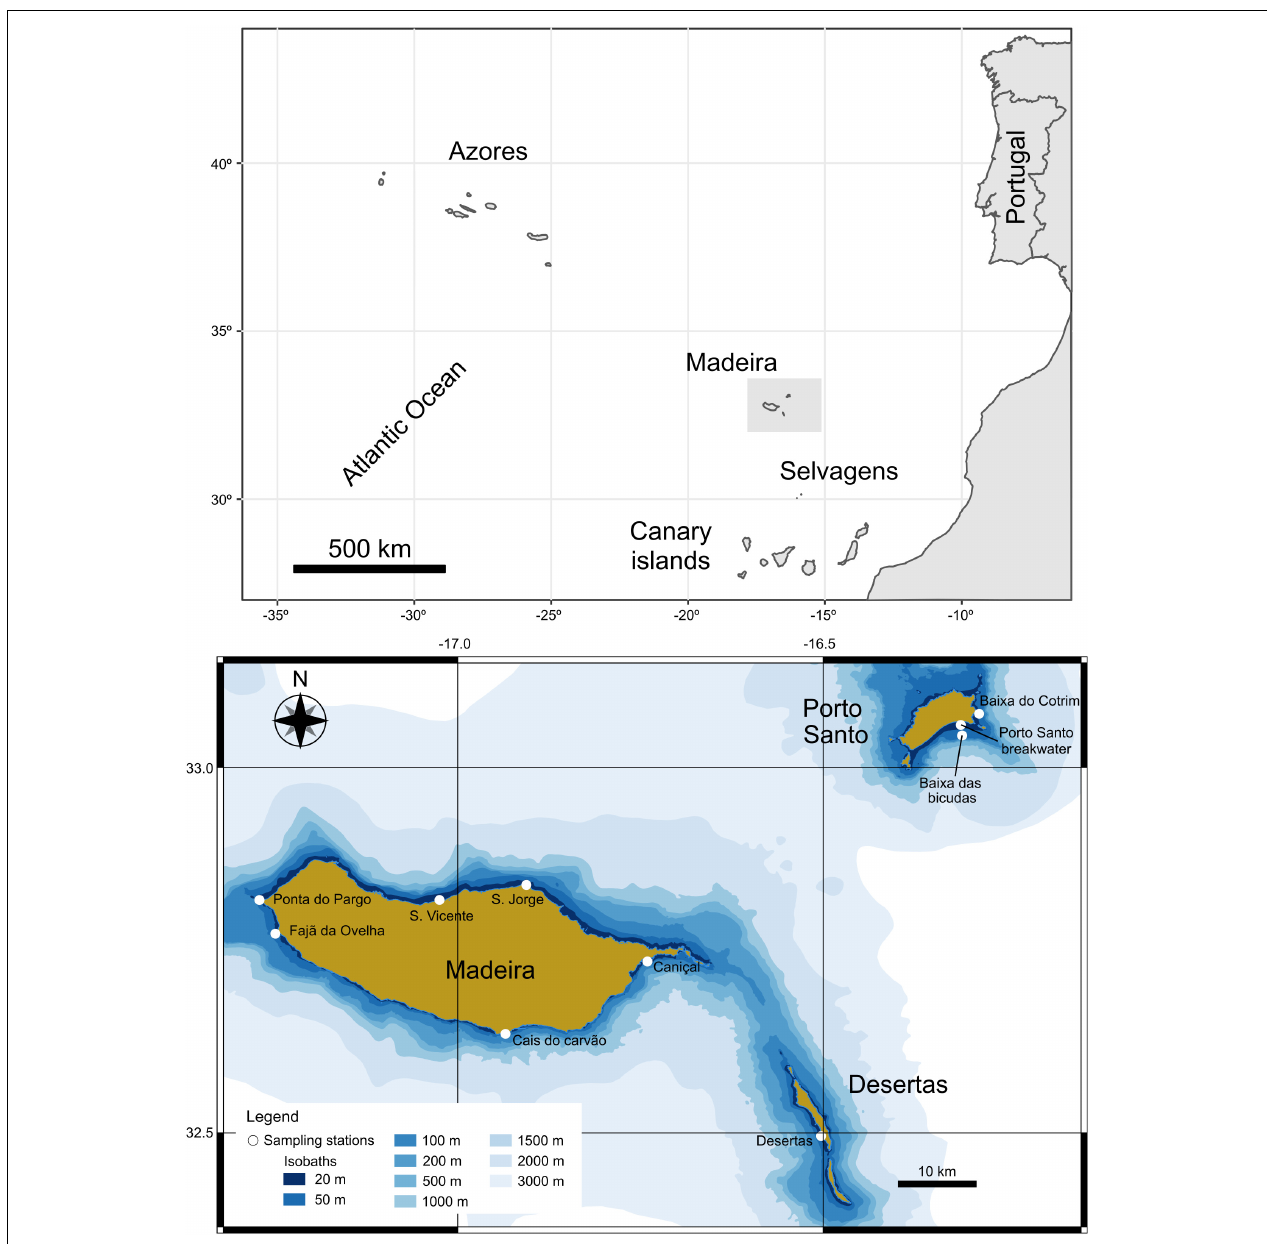
FIGURE 1 | Regional context of study area and sampling locations evaluating Sphaerechinus granularis habitat, density and reproductive cycle in Madeira archipelago.